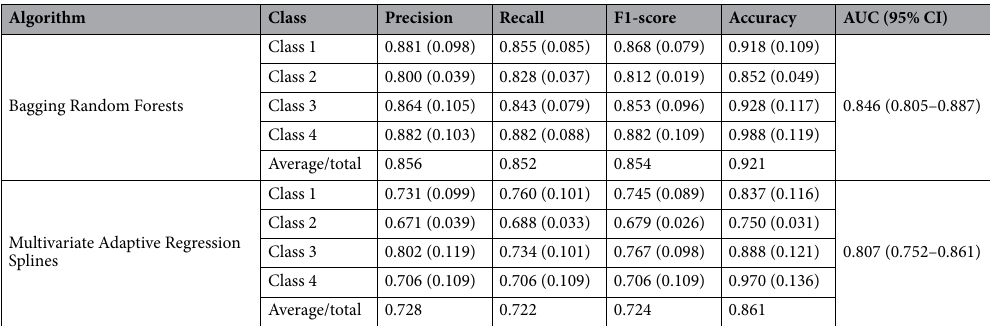
Table 3. The classification power indices (SD) based on the testing set (N = 332) with 1000 bootstrapping samples based on the feature selection methods.